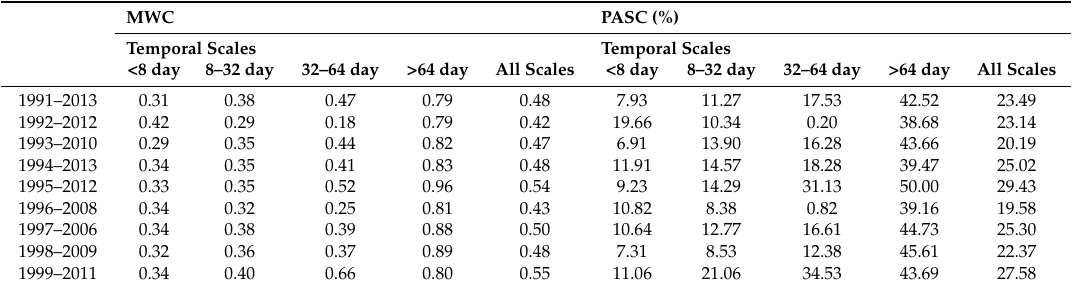
Table 2. Statistical results of wavelet coherence based on correlations and similarities of precipitation patterns in the target years, from 1991 to 1999, and reference years from 2000 to 2013. MWC PASC (%) Temporal Scales Temporal Scales <8 day 8–32 day 32–64 day >64 day All